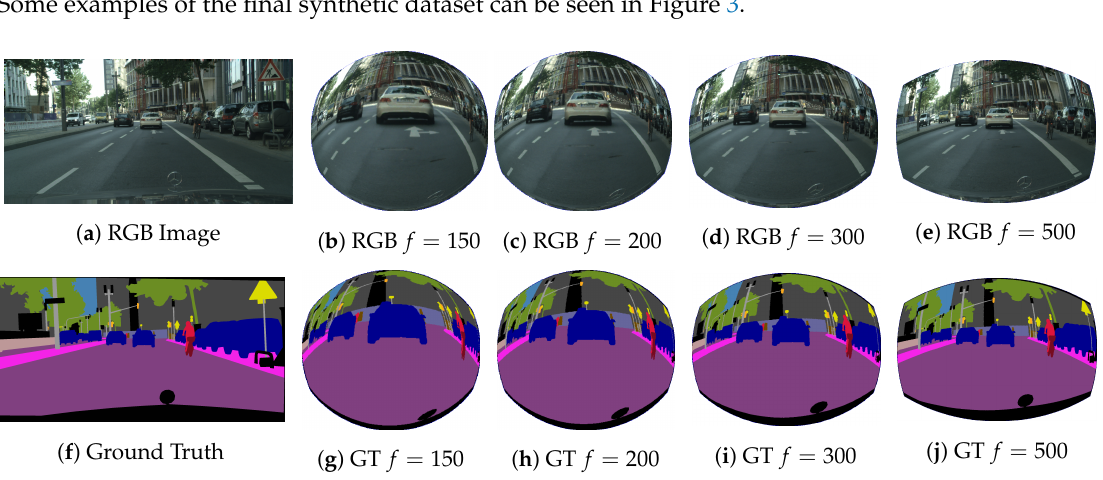
Figure 3. Example of synthetic images and ground truth with different